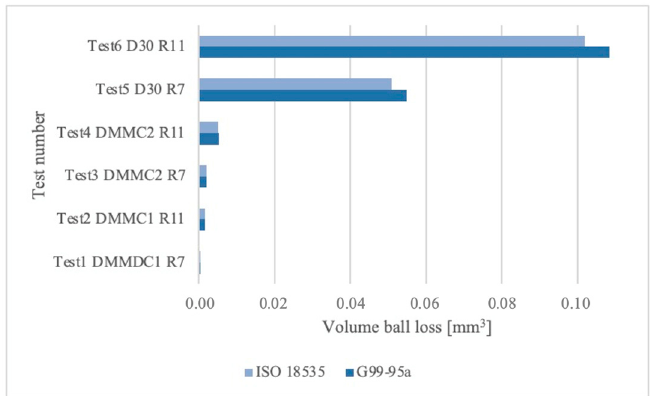
Figure 8. Comparison for ball volume loss calculation methods.